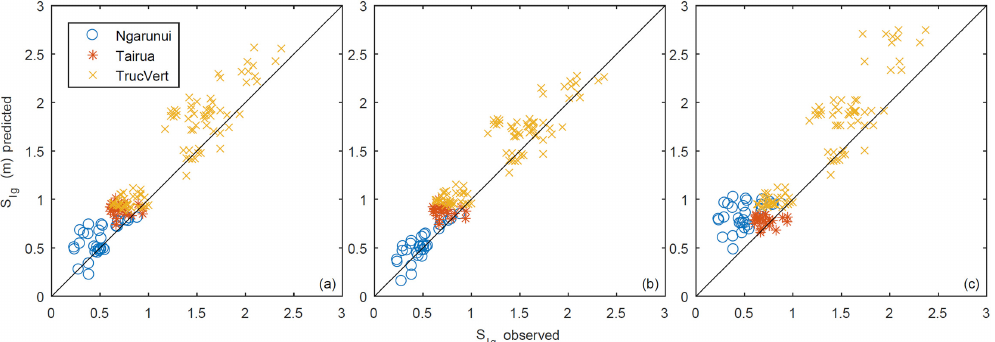
Figure 7. Observed versus predicted S Ig using (a) GP Eq. (13), (b) GP Eq. (14) and (c) Stockdon et al. (2006) Eq. (7) on the new independent data